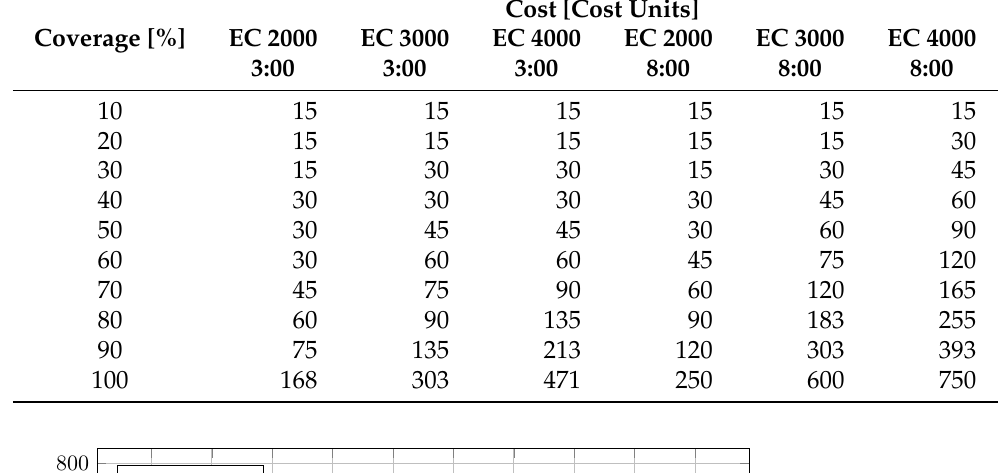
Table 5. Cost function values for the test scenarios of dataset 1. Table 5: Cost function values for test scenarios of dataset 1.